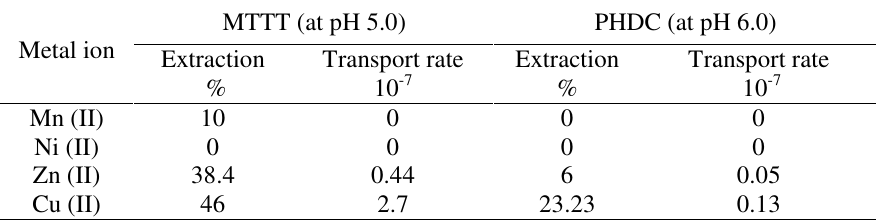
Table 1. The results of competitive metal ion extraction and transport experiments using MTTT and PHDC as carriers at 25°C. The results are mean of triplicate (extraction) and duplicates (transport)